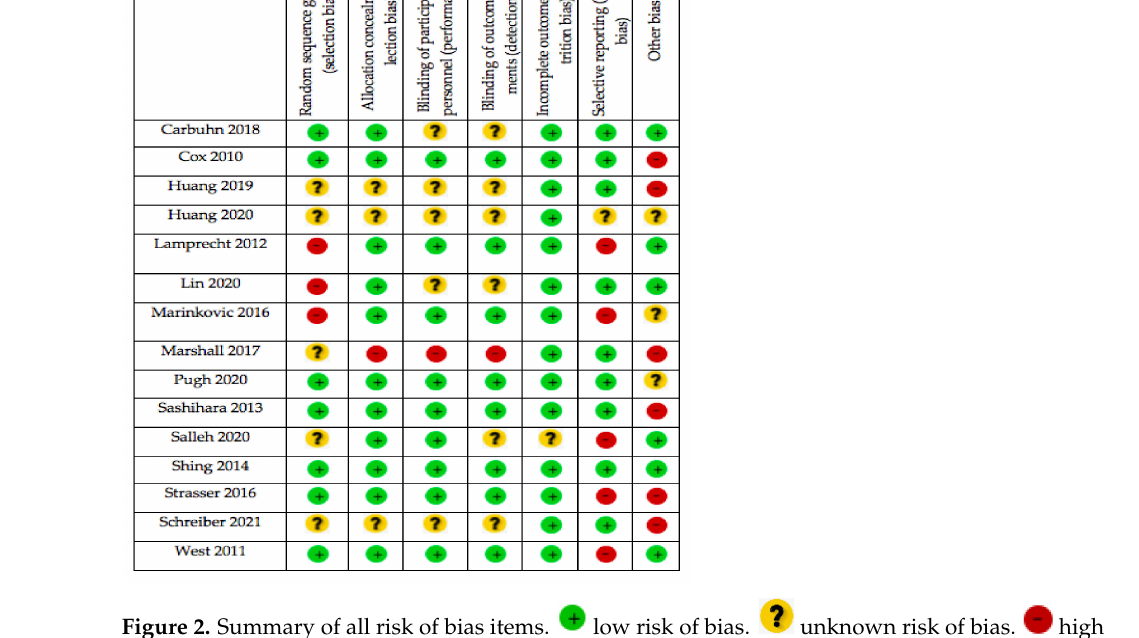
Figure 2. Summary of all risk of bias items. low risk of bias. unknown risk of bias. high risk of bias. Table 2. Physiotherapy Evidence Database (PEDro) scale assessment for the included studies accord- ing to